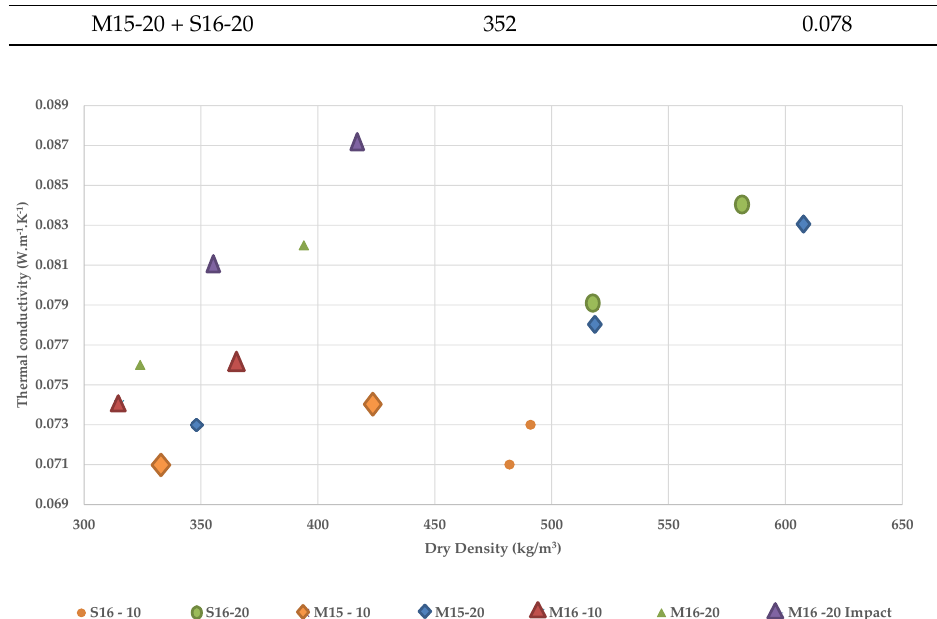
Figure 10. Thermal conductivity as a function of concrete density according to the type of rapeseed aggregates.